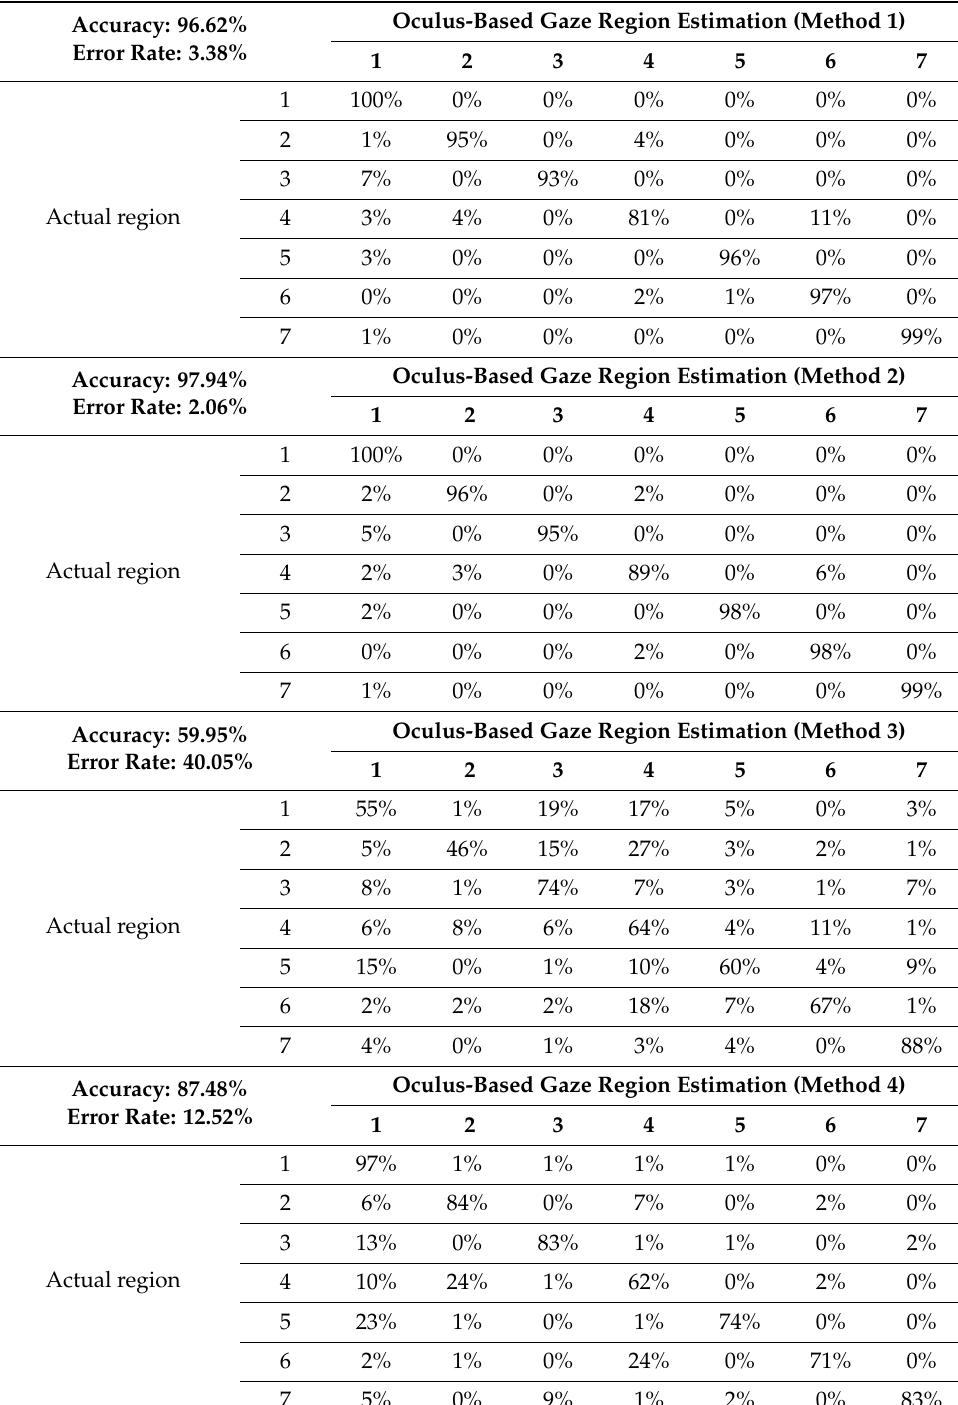
Table 8. Confusion matrices using Oculus for each of the four developed